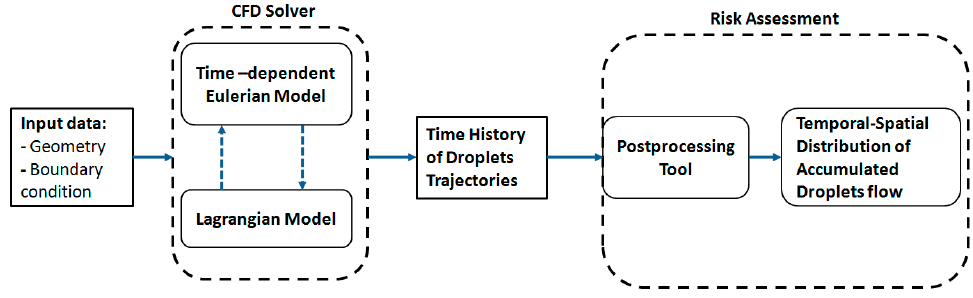
Figure 1. The framework of the risk assessment model (RAM) of pathogen airborne droplet trans- mission.